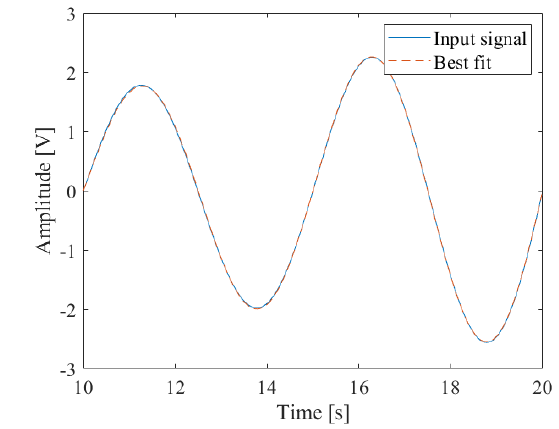
Figure 21. Second 10 s time window of the acquired signal and its estimated best